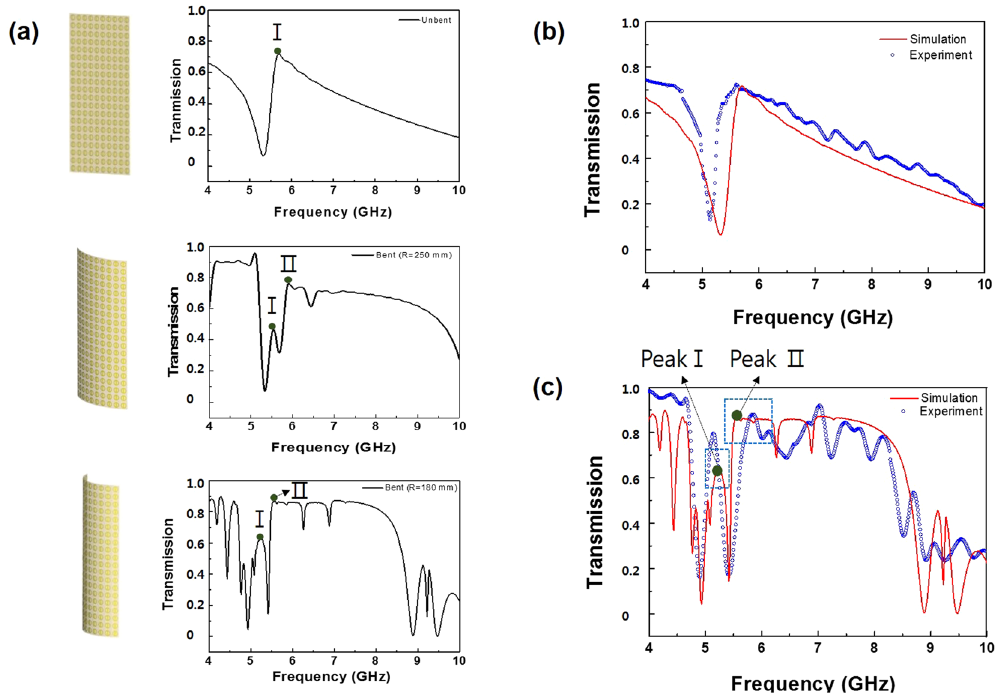
Figure 5. ( a ) Simulated transmission spectra of the MM for different bending strains (R = 250 and 180 mm). Transmission spectra of the CWR-RR structure for the ( b ) unbent and ( c ) the bent state (R = 180